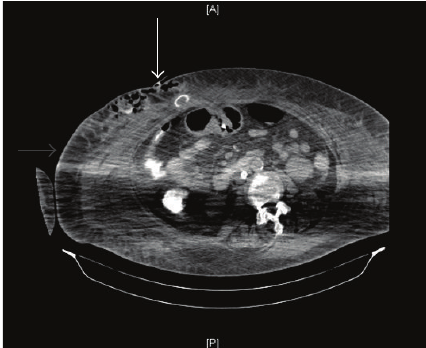
Figure 2: CT image of the abdomen. (1) The solid arrow indicates dislodgement of the internal bumper of the PEG tube into the abdominal wall outside the peritoneum. (2) The hollow arrow shows subcutaneous collection of fluid and air in the abdominal wall.